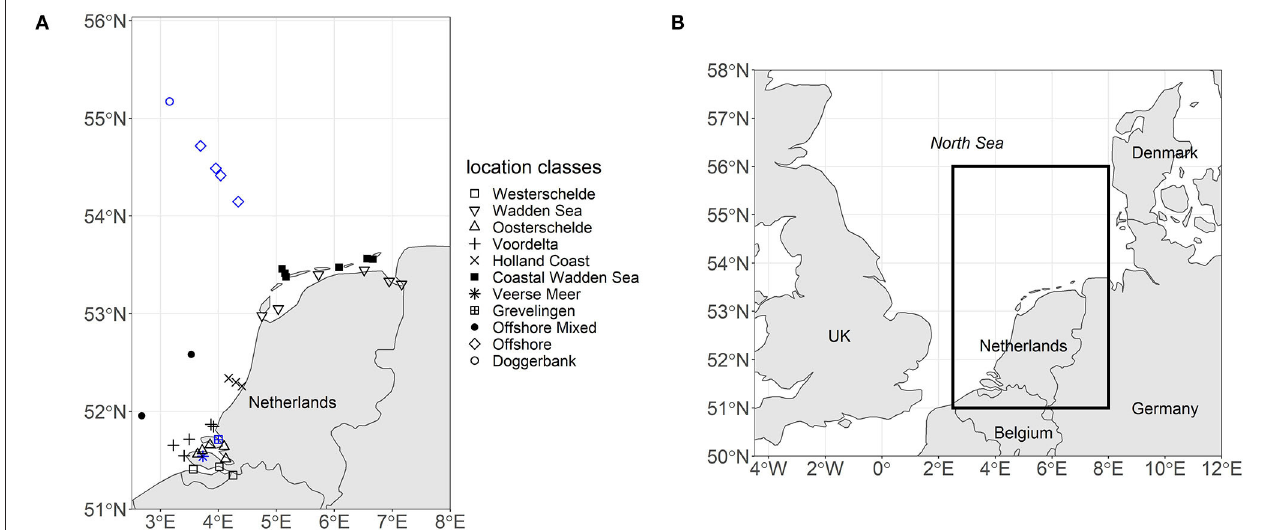
FIGURE 1 | (A) The map displays the locations of the 37 sampling stations in the Southern North Sea labeled according to their location class. Black indicates that only surface samples were taken. Blue indicates that summer stratification occurred and three depths were sampled (surface, pycnocline, and bottom). (B) The map places the sampling region within the context of the North